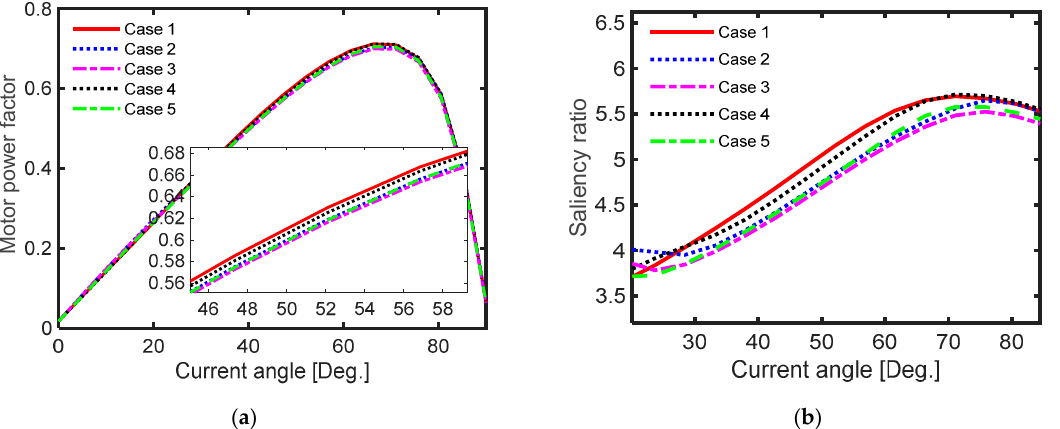
Figure 12. ( a ) Motor power factor and ( b ) saliency ratio at different current angles and at rated conditions for the optimal geometry of different cases.